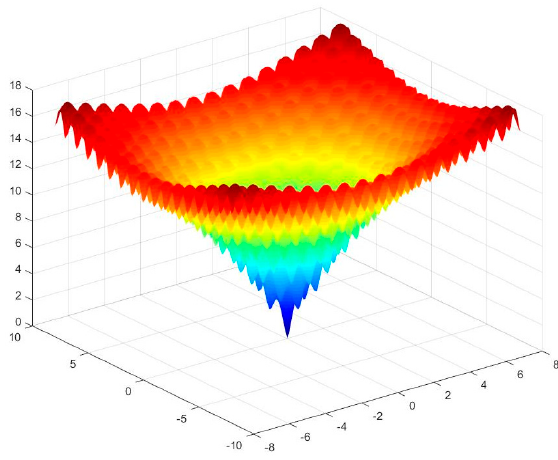
Figure 8. Three-dimensional image of Ackley function ( f 6 ).